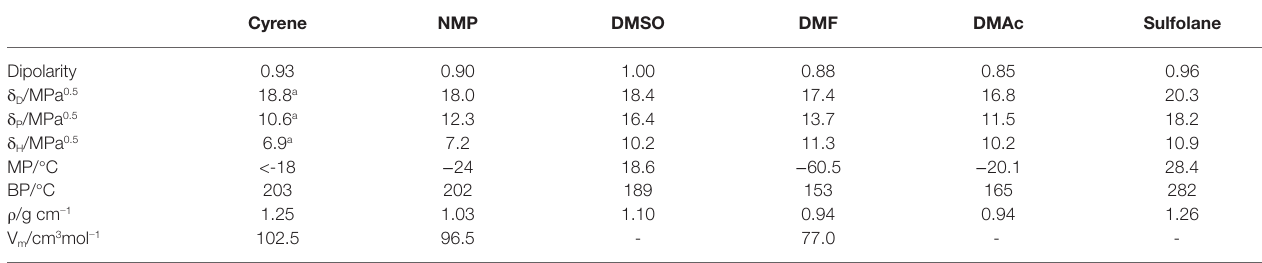
TABLE 3 | Physical properties of some polar aprotic solvents.